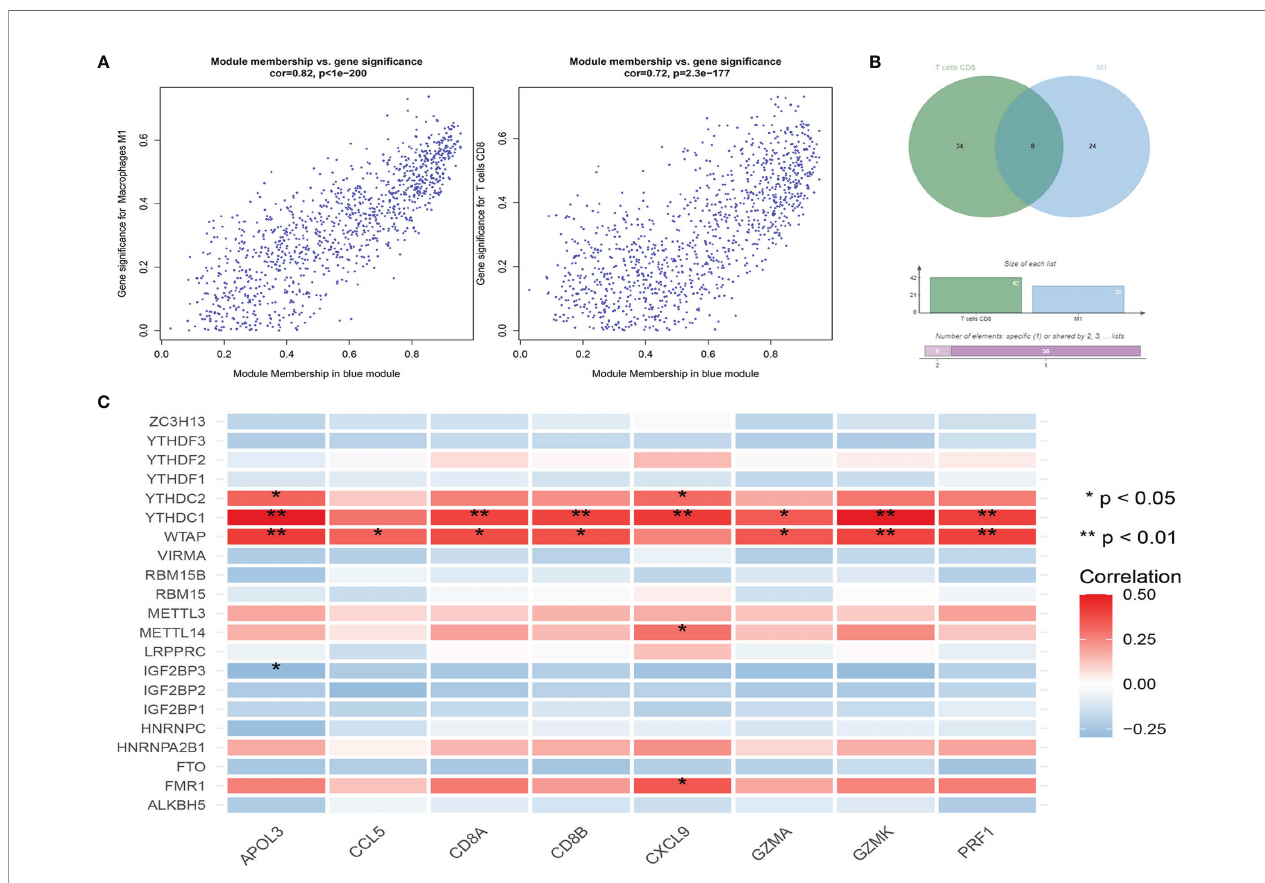
FIGURE 7 | (A) Correlation results between gene expression and module characteristics of signi fi cantly related blue M1 macrophage module and blue CD8+T cell module; (B) Wien diagrams of signi fi cantly related module genes; (C) Correlation analysis between m6A related genes and common genes of signi fi cantly related